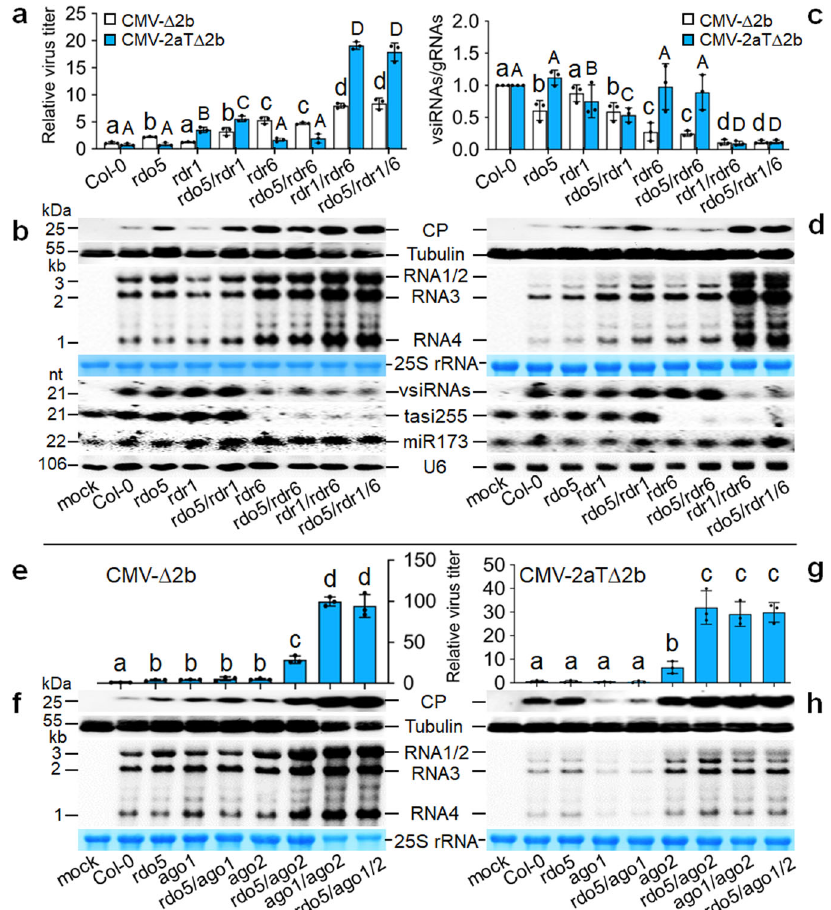
Fig. 2 RDO5 promotes antiviral RNAi. a – h Accumulation of CMV- Δ 2b ( a , b , e , f ) or CMV-2aT Δ 2b ( a , d , g , h ) detected in wild-type (Col-0), single, double or triple mutant plants as indicated at 2 weeks post-infection by ELISA ( a , e , g ) and Western blot analysis of the viral coat protein (CP) or Northern blot analysis of the viral RNAs 1-4 ( b , d , f , h ). Detection of the vsiRNAs and plant endogenous small RNAs ( b , d ), and the calculation of vsiRNAs/gRNAs ratios ( c ) were as described in the legend to Fig. 1. Note the reduced sample loading (to ½) for total proteins and total RNAs ( f ) from ago1 / 2 double mutant plants and rdo5 / ago1 / 2 triple mutant plants infected with CMV- Δ 2b. Data presented are means± SEM from three replicates ( a , e , g ) or independent experiments ( c ), letters indicate groups with signi fi cant differences (one-way ANOVA, Duncan, p < 0.05) and black dots represent the individual values. The experiments in ( b ), ( d ), ( f ) and ( h ) were repeated three times independently with similar results. The source data underlying blots in ( b ), ( d ), ( f ) and ( h ), ELISA data in ( a ), ( e ) and ( g ), and ratio data in ( c ) are provided as a Source Data fi